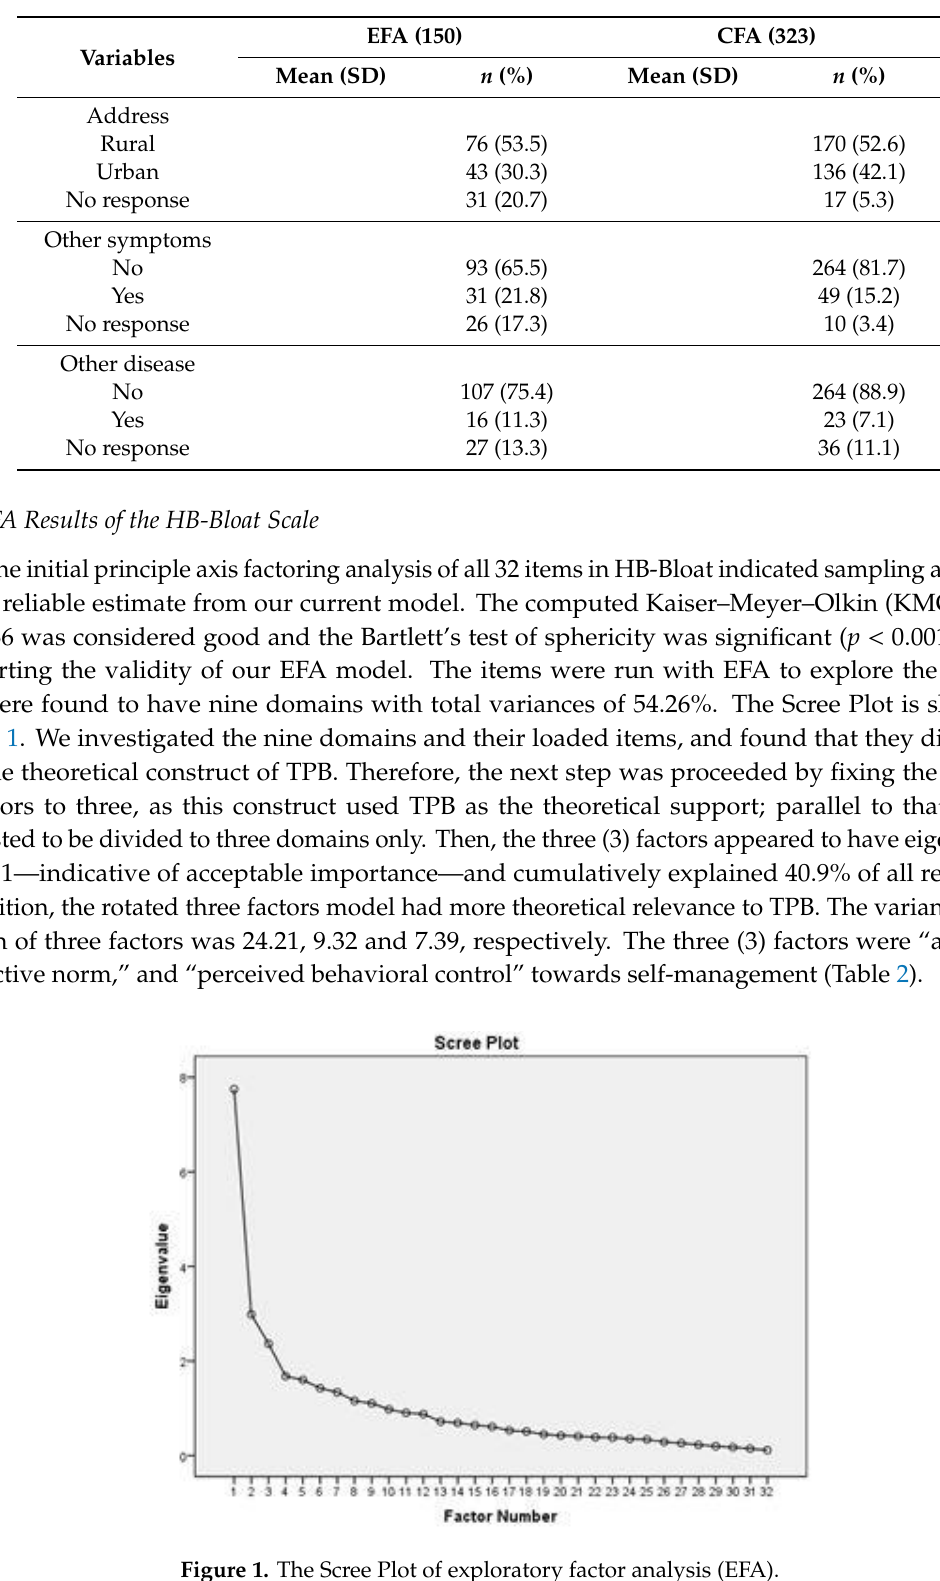
Figure 1. The Scree Plot of exploratory factor analysis (EFA).